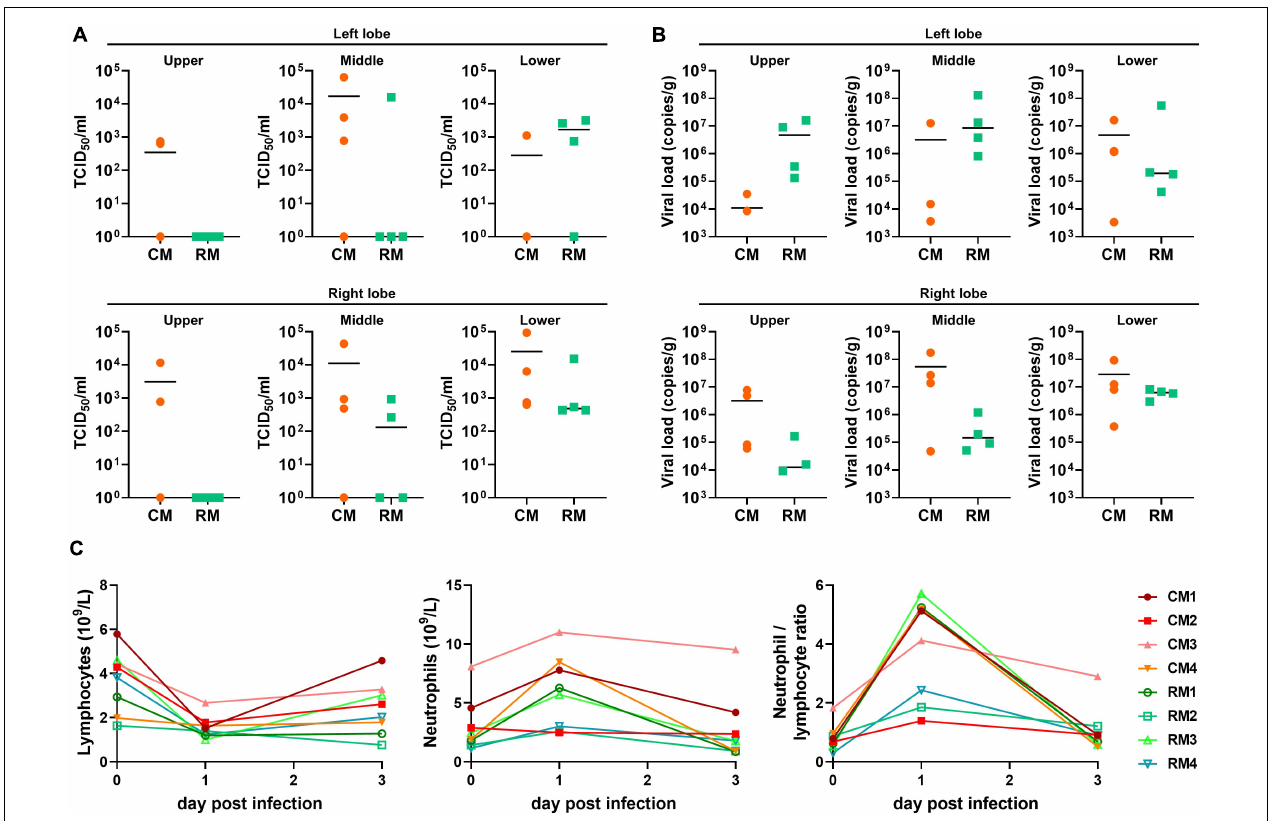
FIGURE 1 | Viral loads in lower respiratory samples and hematological values in cynomolgus and rhesus macaques inoculated with SARS-CoV-2. At 3 dpi, the six lobes of lungs were collected; viral loads in all lobes were determined by (A) TCID 50 and (B) qRT-PCR. The bars indicate the median value of viral loads in each animal. (C) The values of hematology were evaluated at 1 and 3 dpi.